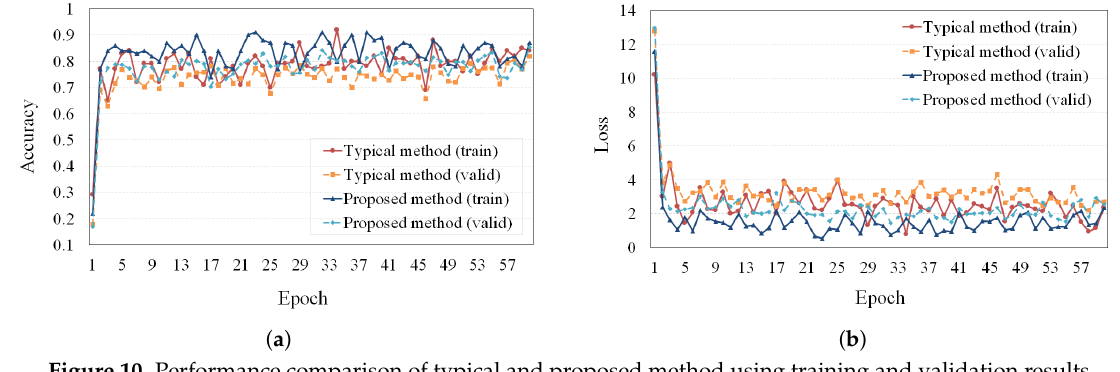
Figure 10. Performance comparison of typical and proposed method using training and validation results ( a ) accuracy, ( b ) loss. Since MNIST consists of 60,000 training data and mini-batch is set to 100, 1 epoch is 600 iterations in probability.